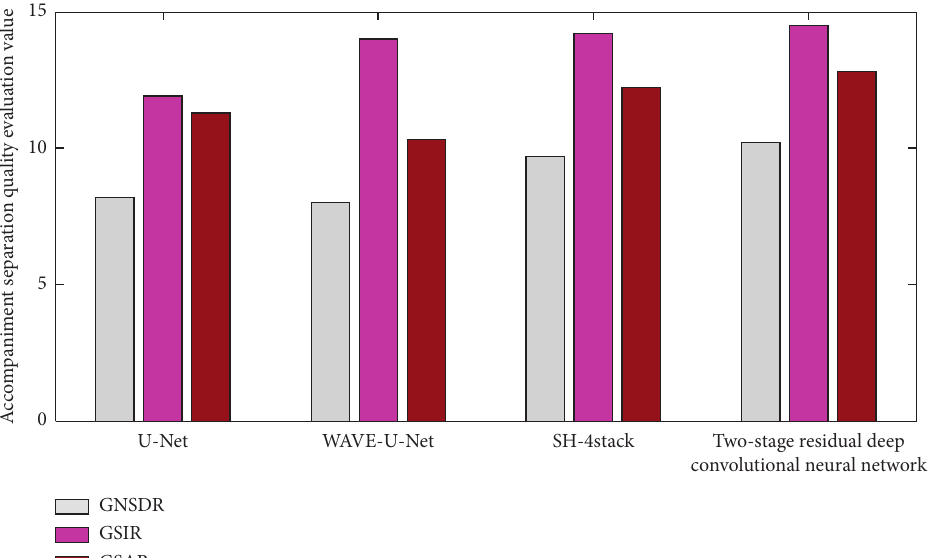
Figure 5: Overall assessment of the quality of accompaniment separation.